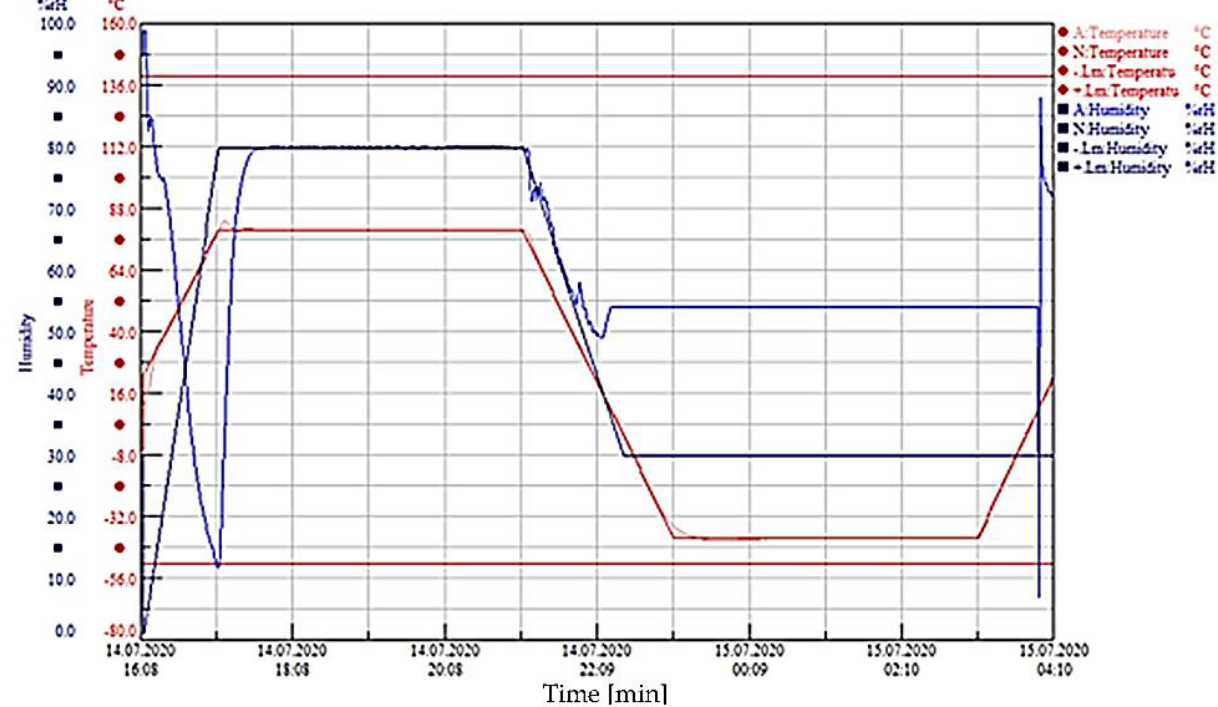
Figure 2. Thermal cycle suggested by the PV1200 standard and applied in this study [32].